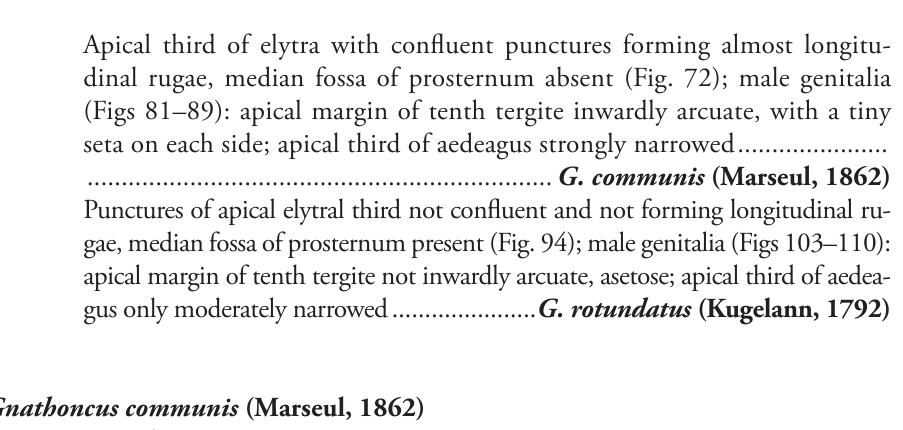
Apical third of elytra with confluent punctures forming almost longitu- dinal rugae, median fossa of prosternum absent (Fig. 72); male genitalia (Figs 81–89): apical margin of tenth tergite inwardly arcuate, with a tiny seta on each side; apical third of aedeagus strongly narrowed ...................... .................................................................... G. communis (Marseul, 1862) Punctures of apical elytral third not confluent and not forming longitudinal ru- gae, median fossa of prosternum present (Fig. 94); male genitalia (Figs 103–110): apical margin of tenth tergite not inwardly arcuate, asetose; apical third of